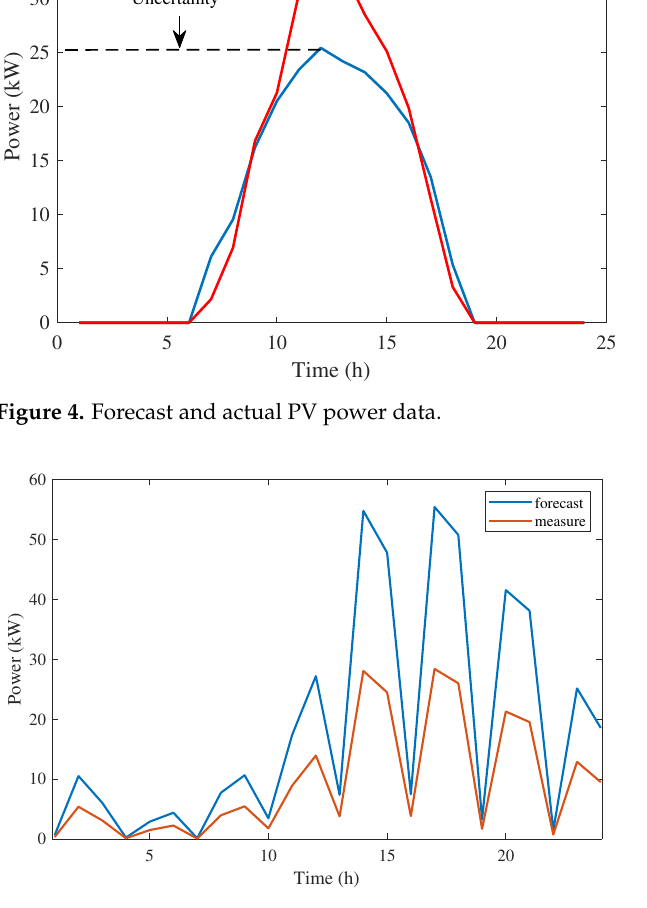
Figure 5. Forecast and actual wind power data.